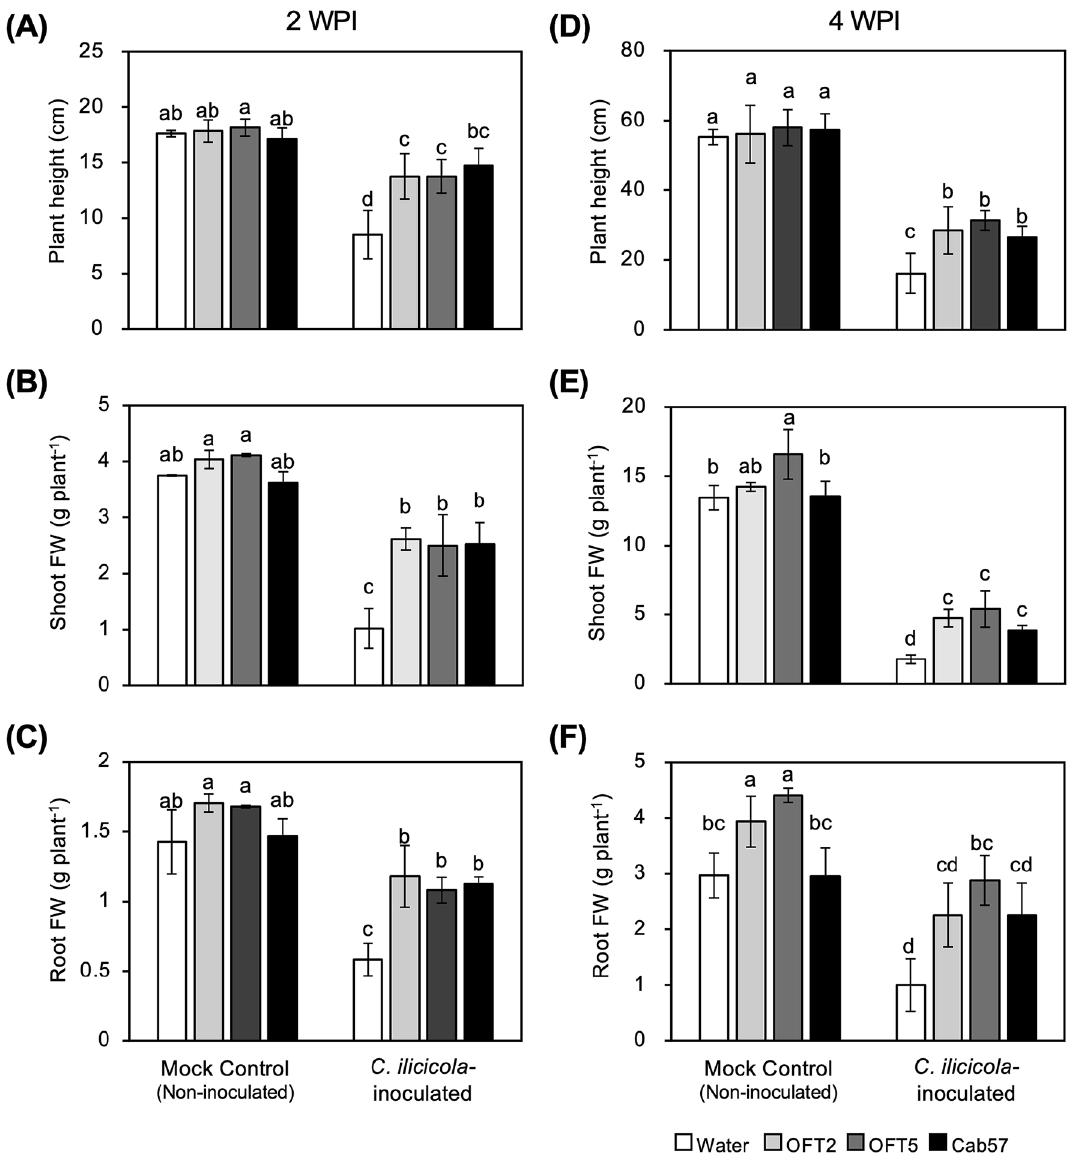
Figure 4. Effects of Pseudomonas strains (OFT2, OFT5, and Cab57) on the ( A , D ) plant height, ( B , E ) shoot fresh weight, and ( C , F ) root fresh weight of soybean bean plants inoculated or non-inoculated with C. ilicicola (UH2-1) at ( A – C ) 2-WPI and ( D – F ) 4-WPI (n = 20). Different letters next to error bars indicate that the means are significantly different from each other as per Tukey’s HSD test (p <